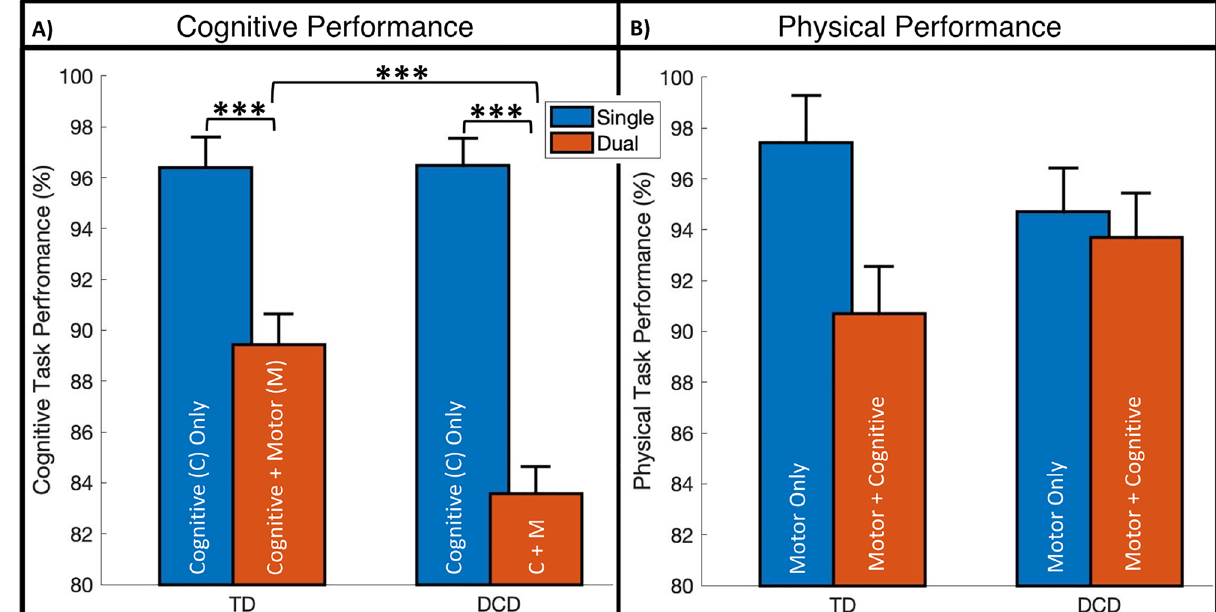
Figure 1. Cognitive Task Performance (%) and Physical Task Performance (%) between group (DCD and TD) per task condition (Single and Dual) for 85 subjects with error bars representing standard error of the mean. Increased values indicate better performance. (* p < 0.05; ** p < 0.01; *** p < 0.001). ( A ) Single task is the cognitive only task, while dual task is with the additional motor task. ( B ) Single task is the motor only task, while the dual task is with the additional cognitive